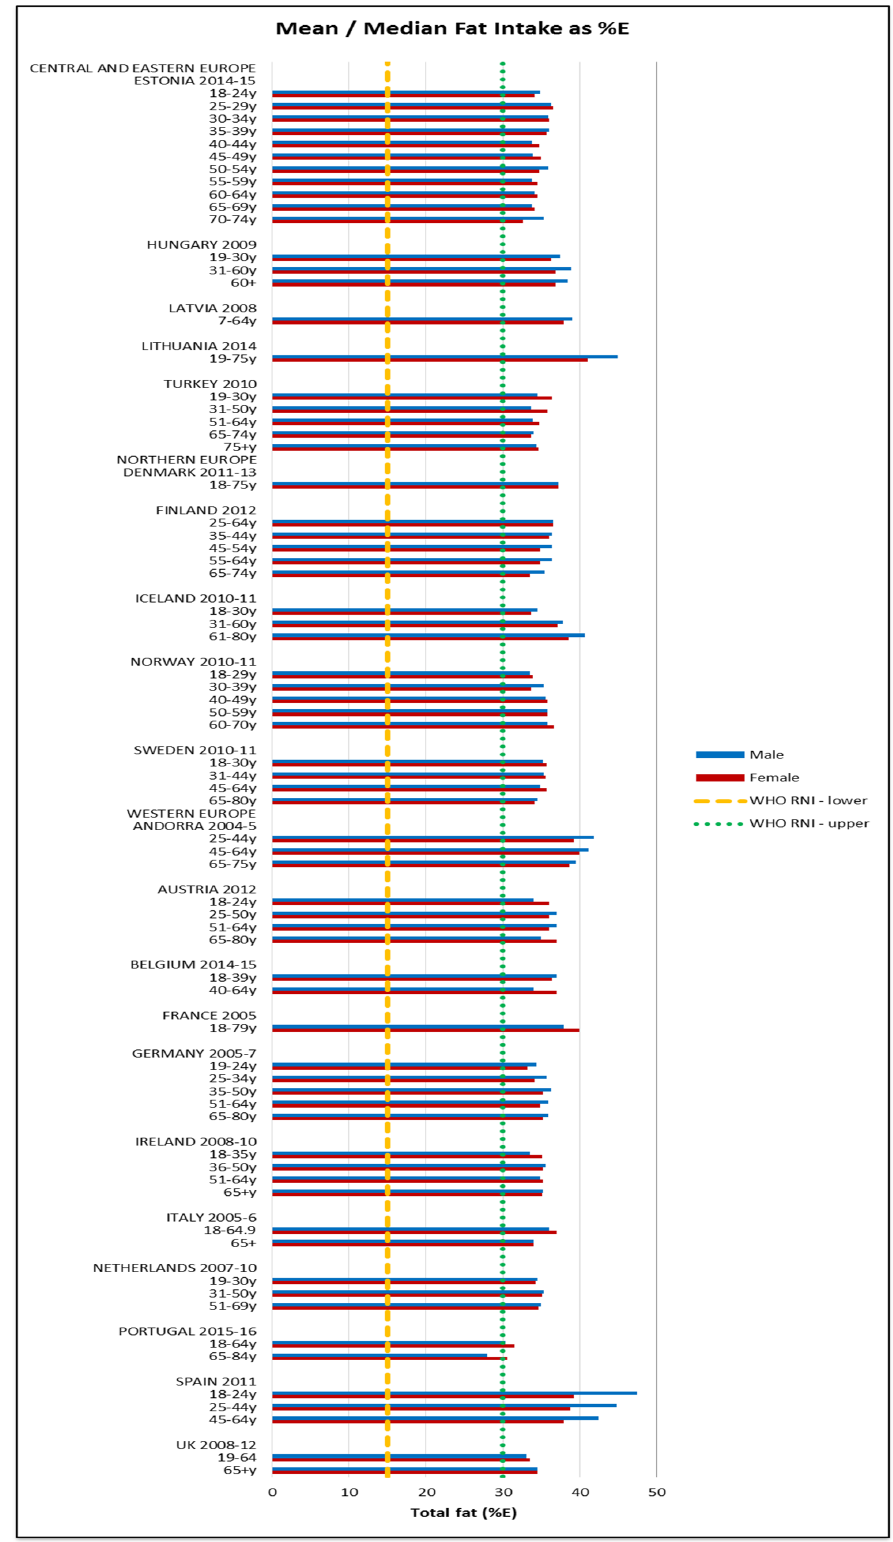
Figure 7. Mean/median* adult fat intake (g/day) (excluding supplements). * Figures for Spain are based on median rather than mean values.